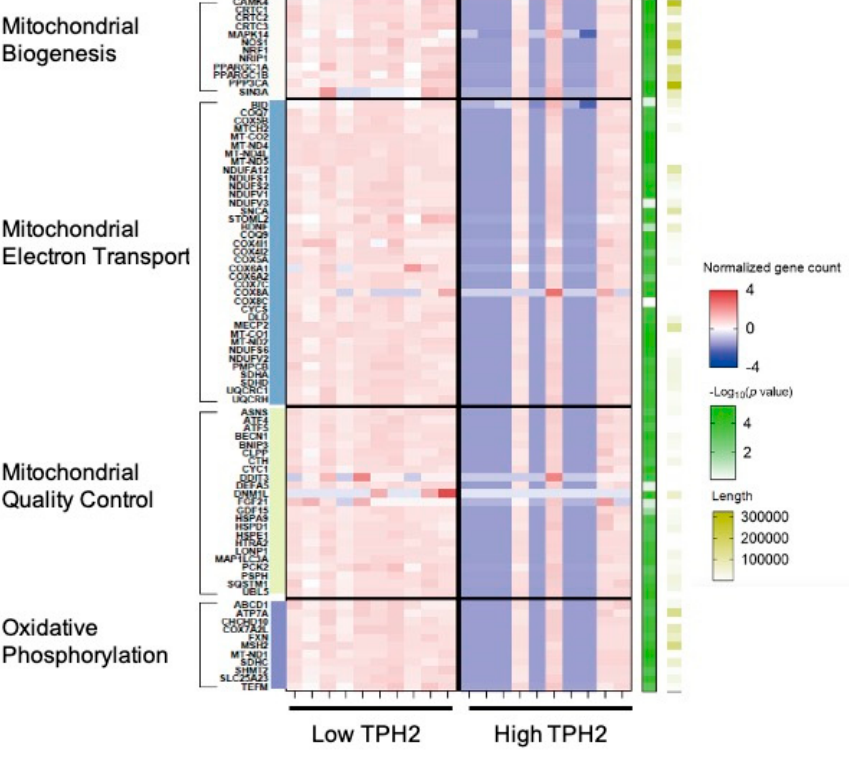
Figure 5. The heat map of DEGs related to mitochondrial biogenesis, energy metabolism, and mitochondrial quality control according to TPH2 expression in brain ( n = 10 per group).